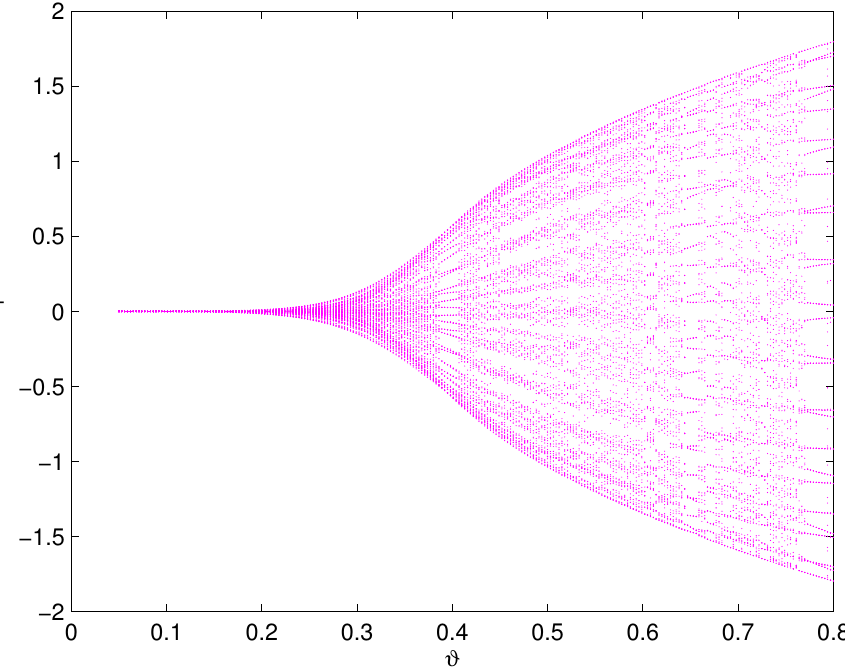
Figure 3. Bifurcation graph of system (71): the time delay ϑ versus the variable w 1 . The bifurcation number is